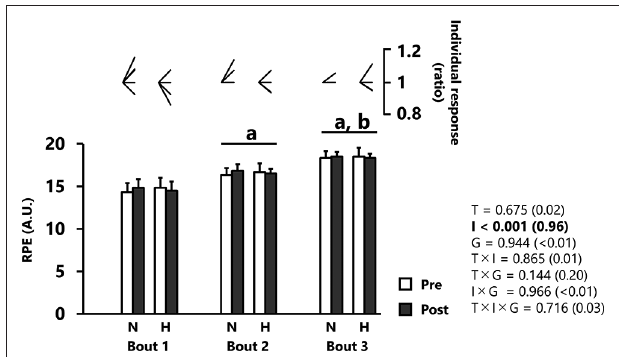
FIGURE 4 | Rating of perceived exertion (RPE). All values are expressed as mean with SD for error bars. Individual response is shown as a ratio of the value between pre and post within participants. Significance level and effect size are expressed as P -value (Cohen’s d ) for main effects and interactions. a p < 0.001 Compared with bout 1. b p < 0.001 Compared with bout 2. N, normoxic group; H, hypoxic group; T, time; I, interval; G,